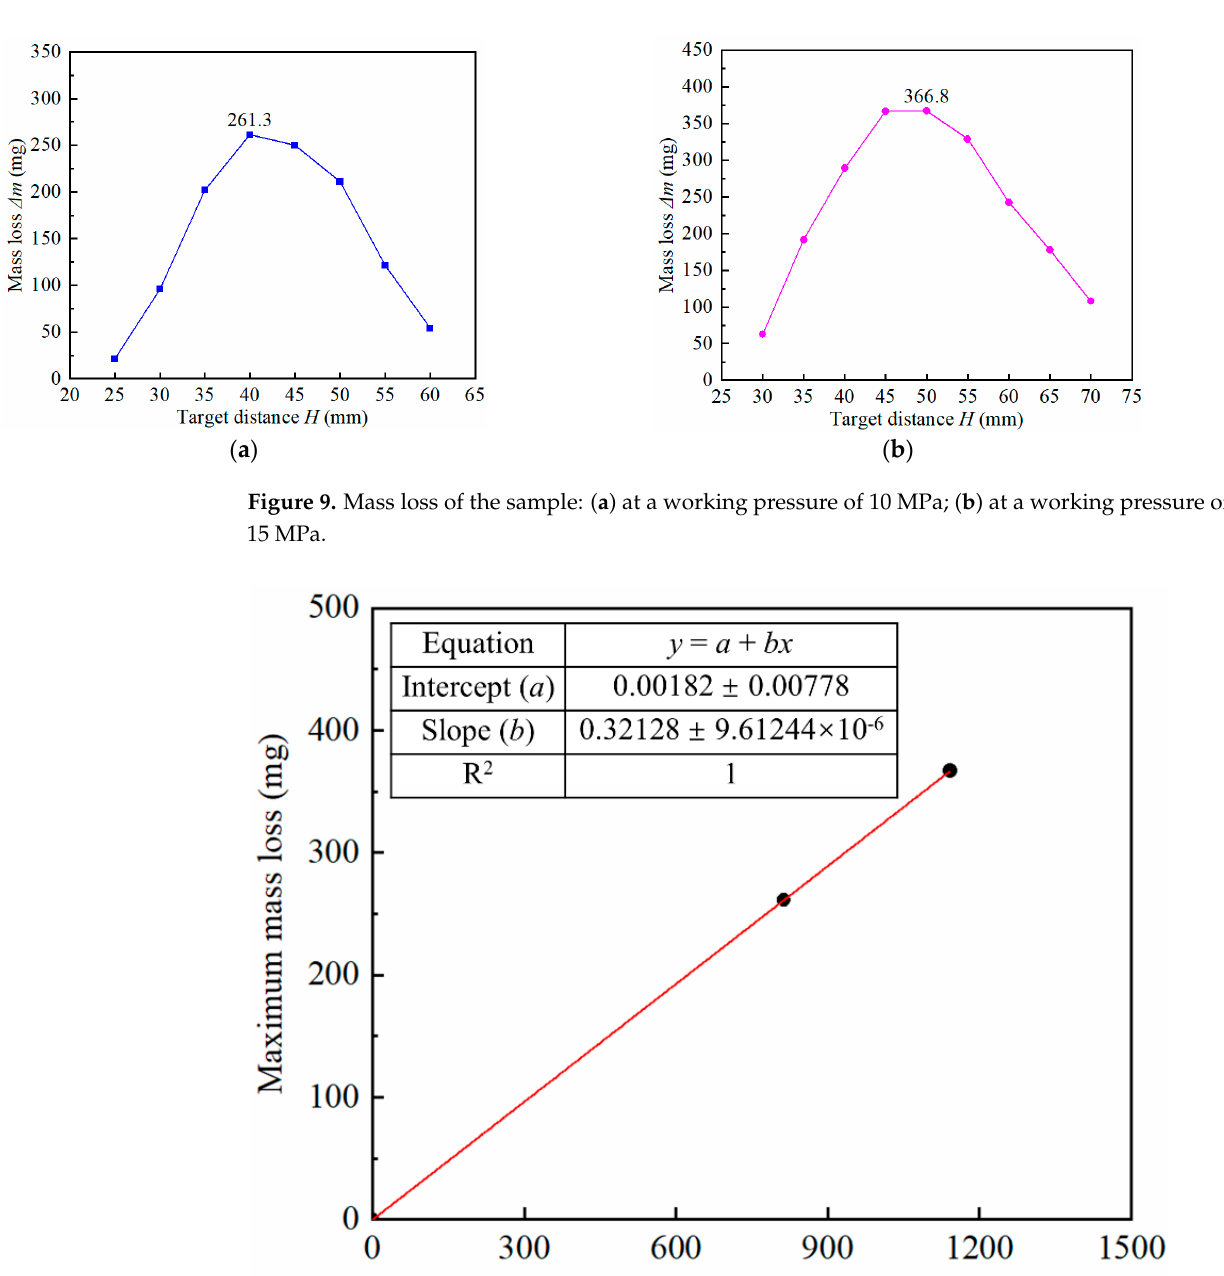
Figure 10. Fitting curve of dimensionless cumulative cavitation intensity and maximum mass loss.